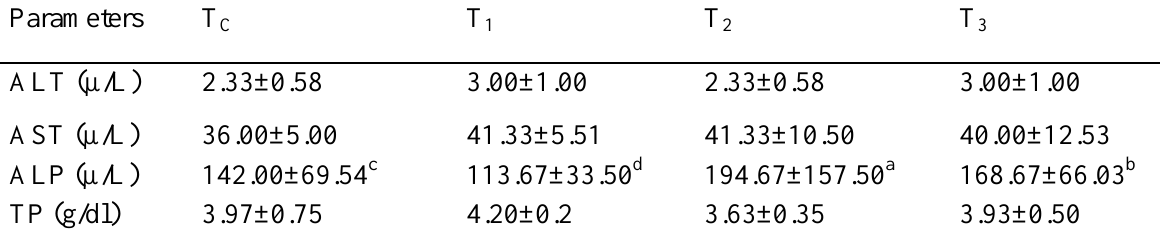
Table 2: The effects of turmeric ( Curcuma longa ) on the serum biochemical profile of broiler chickens